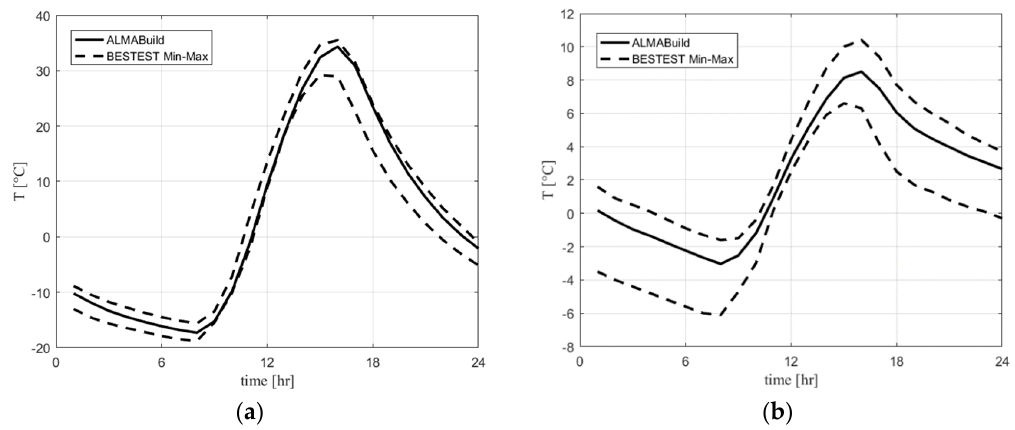
Figure 6. Trend of hourly free-floating internal air temperature for Case 600 FF ( a ) and Case 900 FF ( b ): comparison with the BESTEST limits.